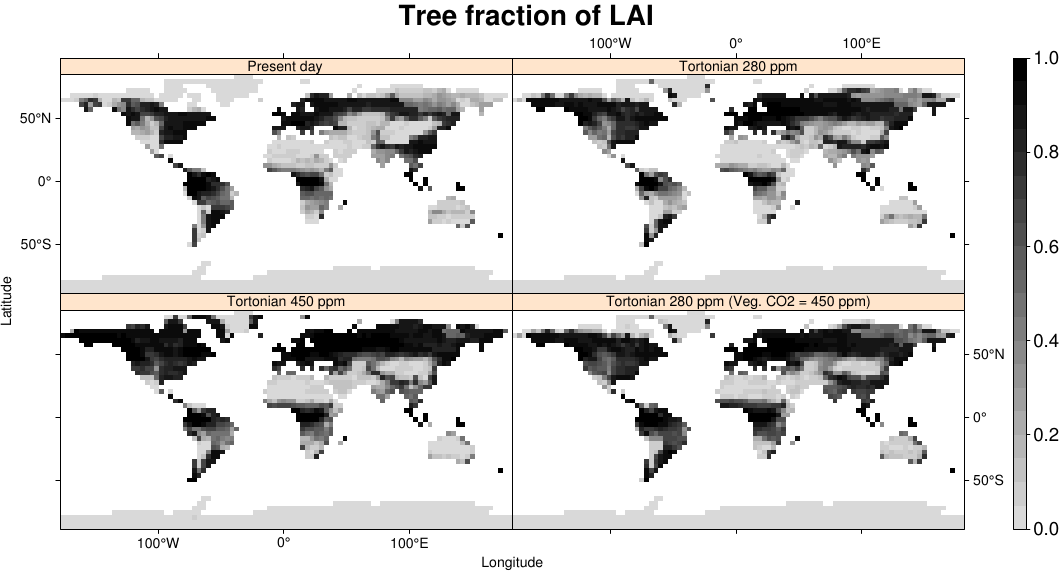
Figure 4. Modelled tree fraction of leaf area index (LAI) for present-day simulation, Tortonian 280ppm CO 2 , and Tortonian 450ppm CO 2 concentrations, respectively. Shown also is the tree fraction of LAI for a mixed CO 2 forcing in climate and vegetation model. and 450 ppm runs is that the transitions occur further north in the 450 ppm